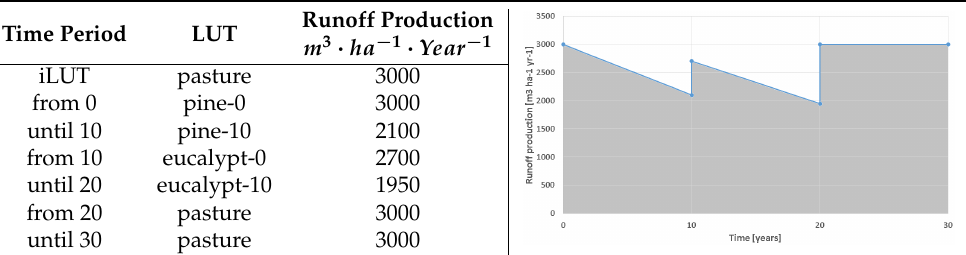
Table 3. Runoff production values and graph for sample land unit and land use trajectory.